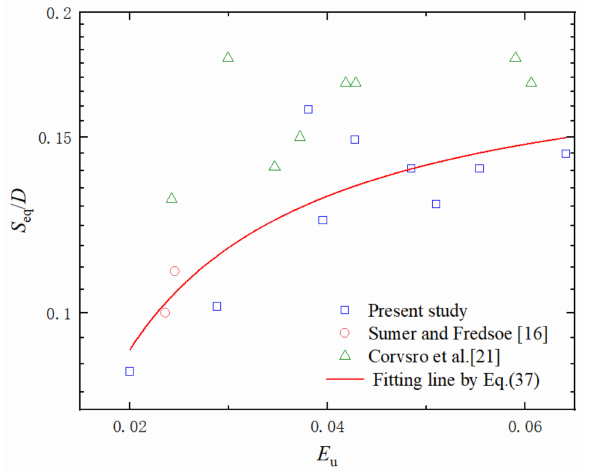
Figure 25. The fitting curve between S eq / D and E u